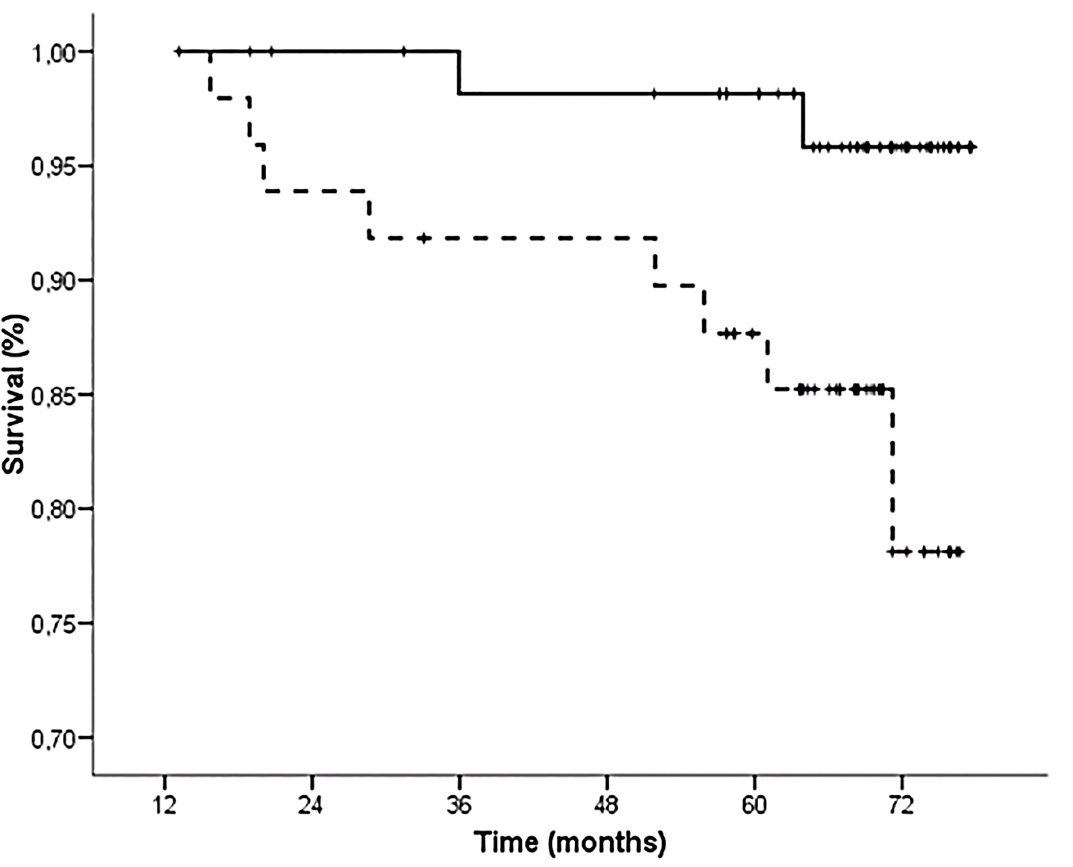
Fig 3. Kaplan-Meier curves according to variation patterns between the c-IMT tertiles at both time periods. Solid line indicates the “ decrease or stable low-middle ” group and dotted line the “ increase or stable high ” group (log-rank analysis 5.4; P =